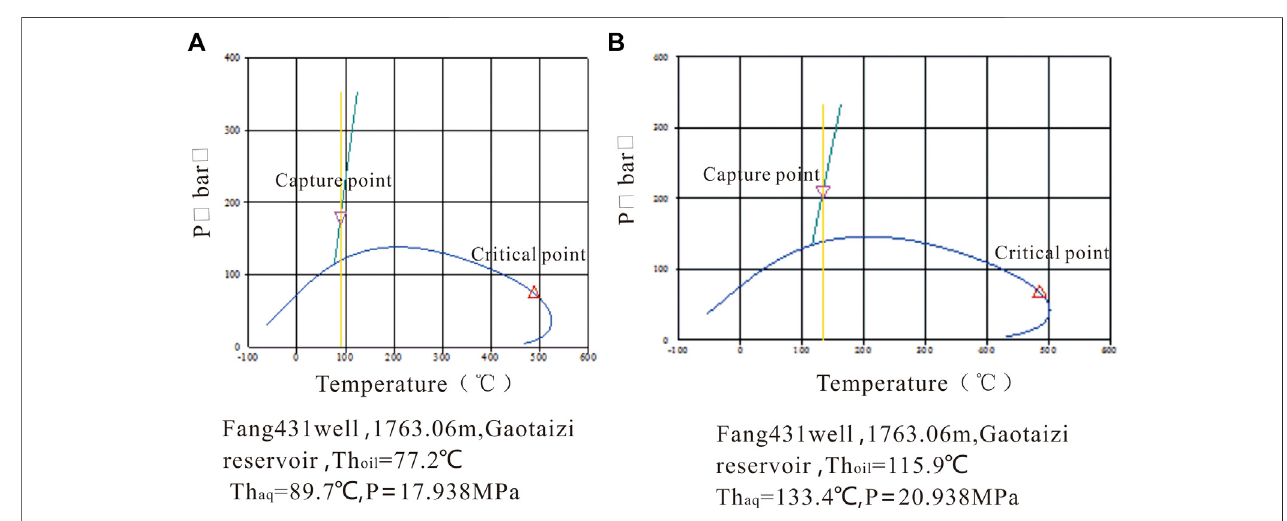
FIGURE 6 | PVTx simulation results and P – T diagram of fl uid inclusion assemblages in the Fang-431 well in the Fuyu oil reservoir.